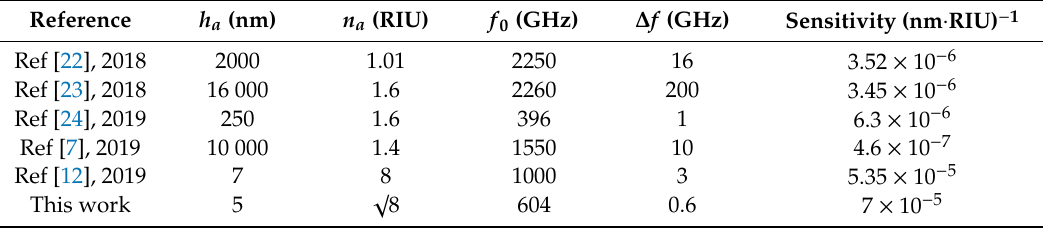
Table 2. Comparison of di ff erent values of sensitivity achieved in di ff erent works, calculated as S = ( ∆ f / f 0 ) / ( h a · n a ), with h a the analyte thickness and n a the analyte refractive index, in refractive index units (RIU), and ordered chronologically.